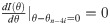
Mathematical and computer simulation analysis of EDC1.(A) Numerical solutions of parameters that fit the mathematical requirements for normal orixate phyllotaxis in EDC1. The two curves show the solutions obtained using various G values. The closed circles indicate the solutions obtained with G set at 0.1 intervals between 0.1 and 1.0. (B) Stable patterns generated in computer simulations using EDC1 under various parameter settings (201 settings for a, 101 settings for b, 3 settings for G, and thus 201×101×3 = 60,903 simulations in total). The patterns obtained are displayed according to the color legend shown in Fig 3. The white crosses (+) indicate the parameter conditions obtained as numerical solutions of dI(θ)dθ|θ−θn−4i=0=0, giving a minimum of I(θ) around θn−4i for normal orixate phyllotaxis, whereas white saltires (×) indicate the parameter conditions obtained as numerical solutions of dI(θ)dθ|θ−θn−4i=0=0, giving a maximum of I(θ). (C) Schematic diagrams of typical examples of the phyllotactic patterns generated in the computer simulations. The circled numbers relate the diagrams to the parameter conditions shown in (B).